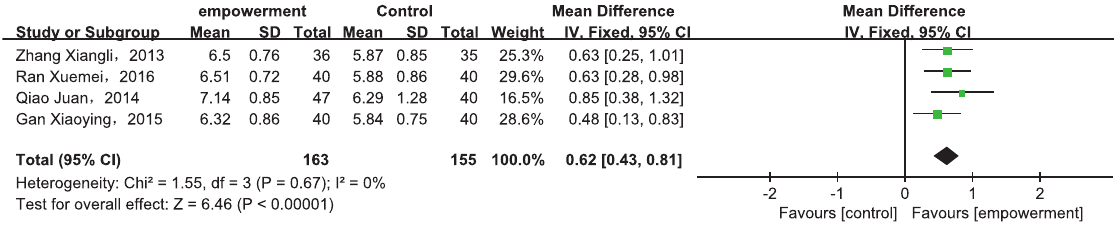
Figure 3. Comparison of 3-month self-efficacy between empowerment education intervention group and traditional education group.